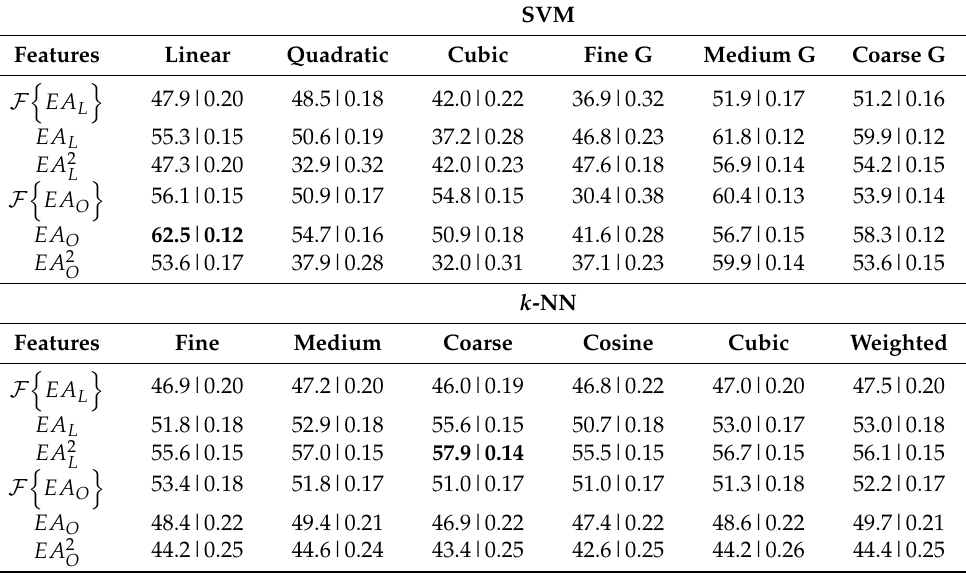
Table 5. Linear wear-state classification results ( % ) and normalised MAE for envelope analysis (EA), where G denotes Gaussian.